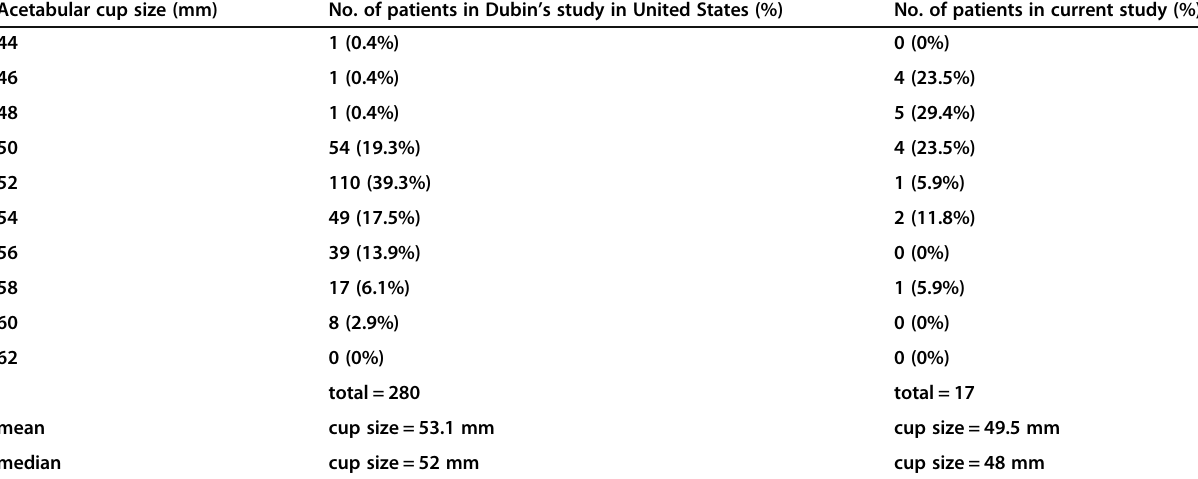
Table 2 – Comparison of Acetabular Cup sizes for patients reported in Dublin ’ s study and in current study Acetabular cup size